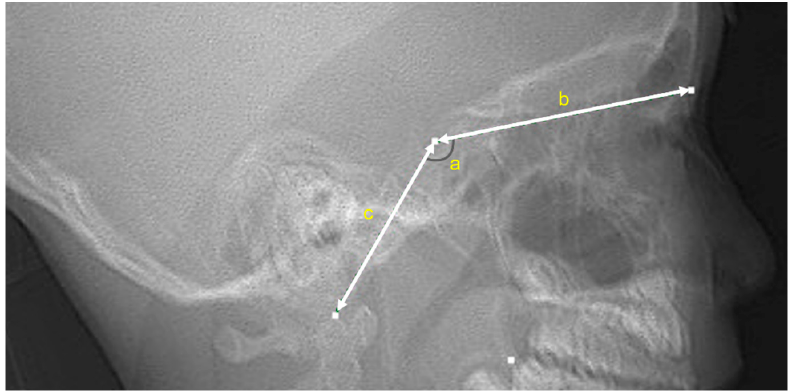
Figure 2. Representative scout image. ( a ) Cranial base angle; ( b ) anterior cranial base length; ( c ) posterior cranial base length. cranial base